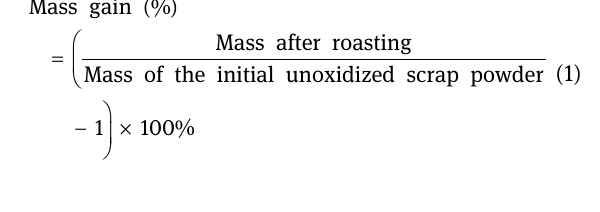
Table 1: Major chemical composition of Nd – Fe – B and Ce – Fe – B scrap ( wt% )